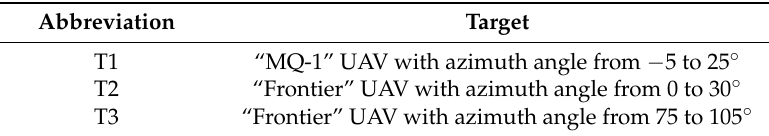
Table 2. The three targets for the experiment.